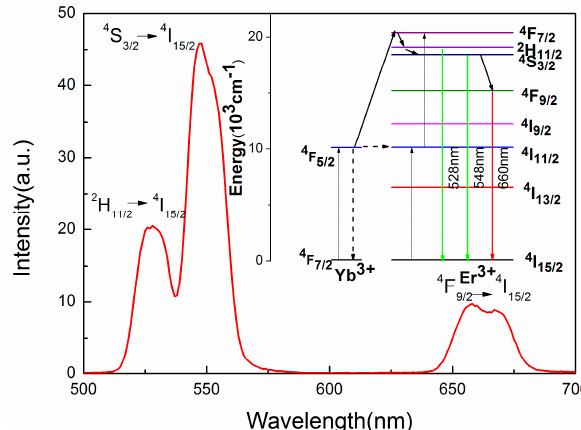
Figure 3. Upconversion luminescence of Er 3+ /Yb 3+ doped TZNb glass. The inset shows the simple energy levels of Er 3+ and Yb 3+ ions and the possible upconversion mechanism in TZNb